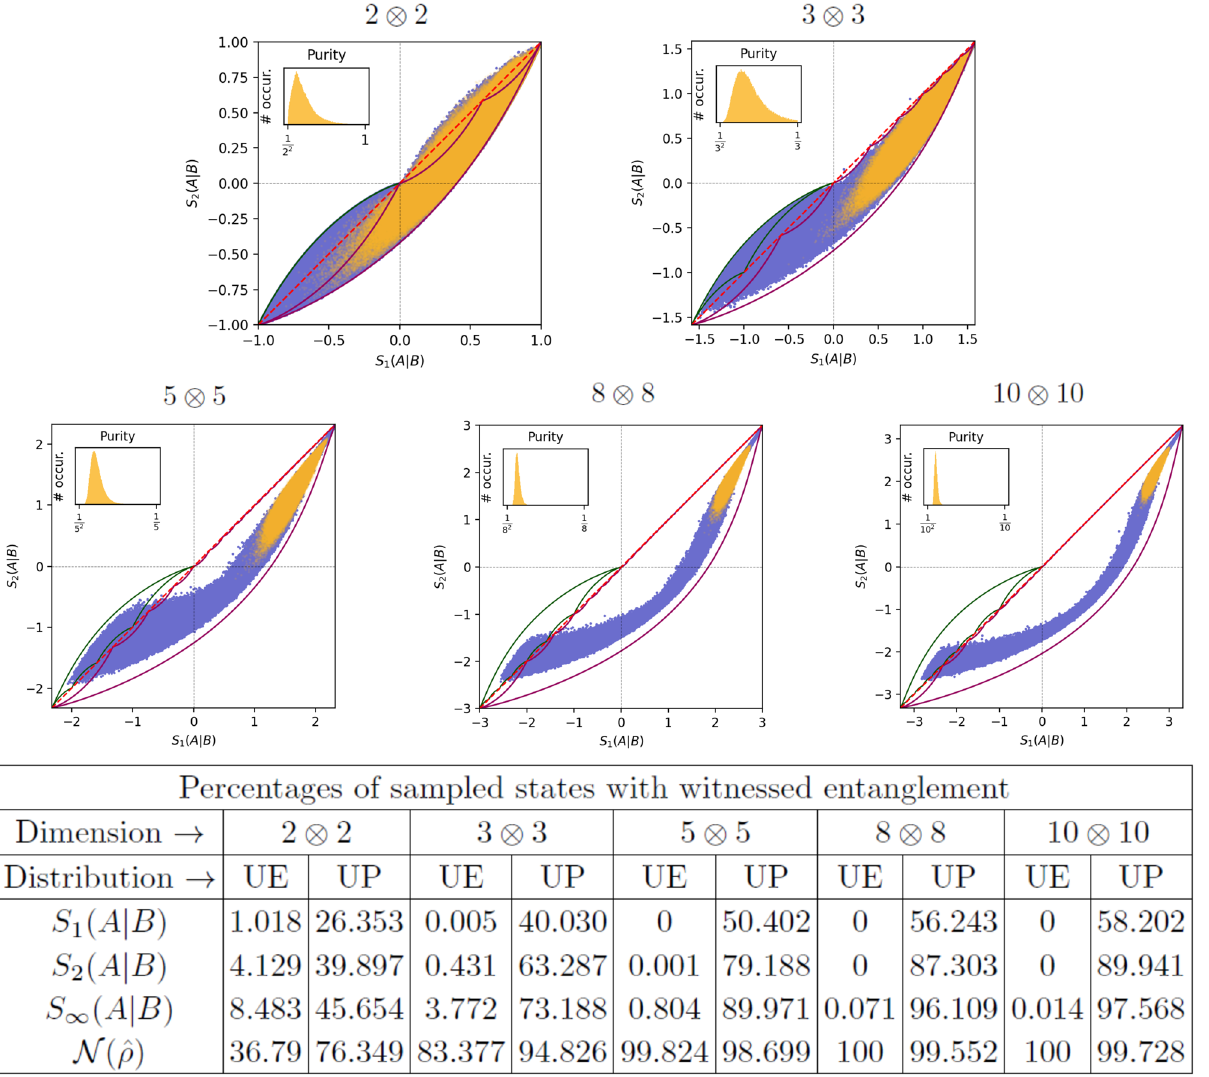
B ) vs S A B ) and respective purity histograms for 10 6 2-quDit systems for Figure 1. (Top) Scatterplots of S 2 ( A 1 ( | | D 2 , 3 3 , 5 5 , 8 8 ,and 10 10 , respectively. The light orange ( 2, 3, 5, 8, 10 ) with each plot labeled 2 ⊗ ⊗ ⊗ ⊗ ⊗ = scatterplots are from the fully uniform ensemble (abbreviated UE) while the blue scatterplots are from the ensemble uniform with respect to purity (abbreviated UP). The inset histograms are of the joint purity of the D pure B ) S A B ) . The set of all D fully uniform ensemble). The red dotted line in each plot is where S 1 ( A 2 ( ⊗ | = | 2 ), states is within the green serrated blade region in the lower left quadrant (or is only a single curve for 2 ⊗ D states with maximally mixed marginals corresponds to the large magenta serrated while the set of all D ⊗ blade spanning three quadrants of the plot. The regions enclosed between the two blades also correspond to valid density matrices. (Bottom) This table gives the percentages of the total number of generated states whose entanglement was witnessed with the function in the first